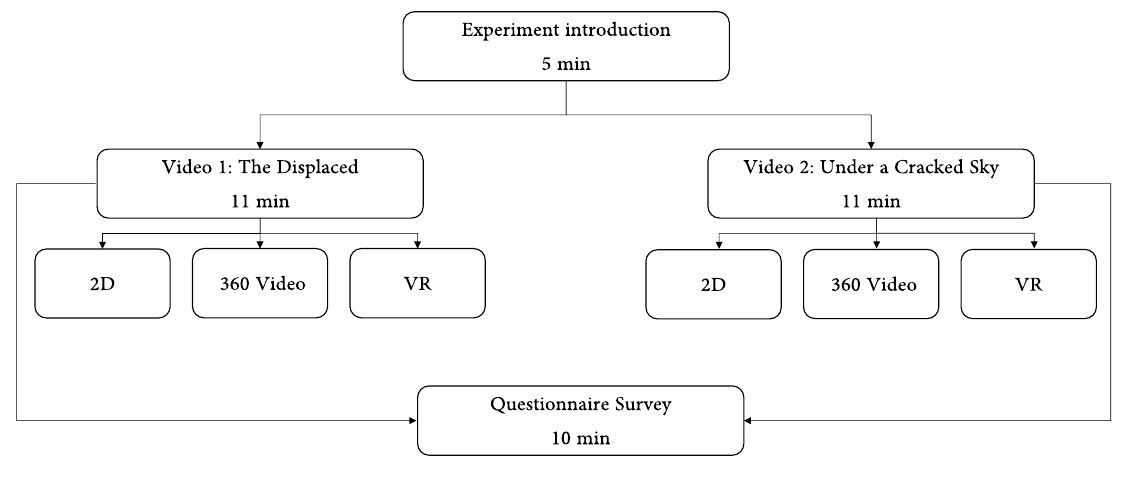
Figure 1. Experimental